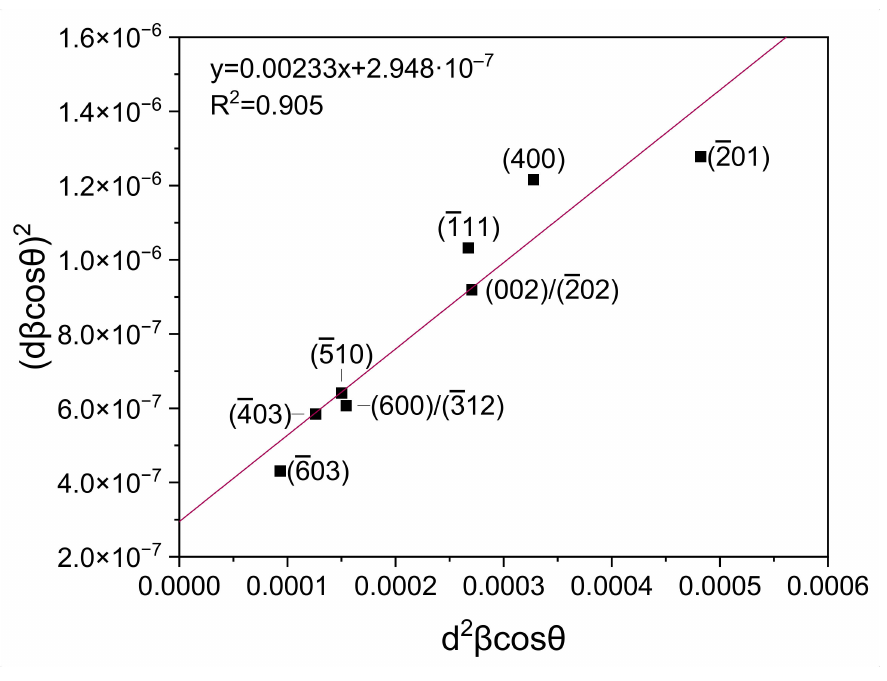
Figure 5. Size-Strain plot.